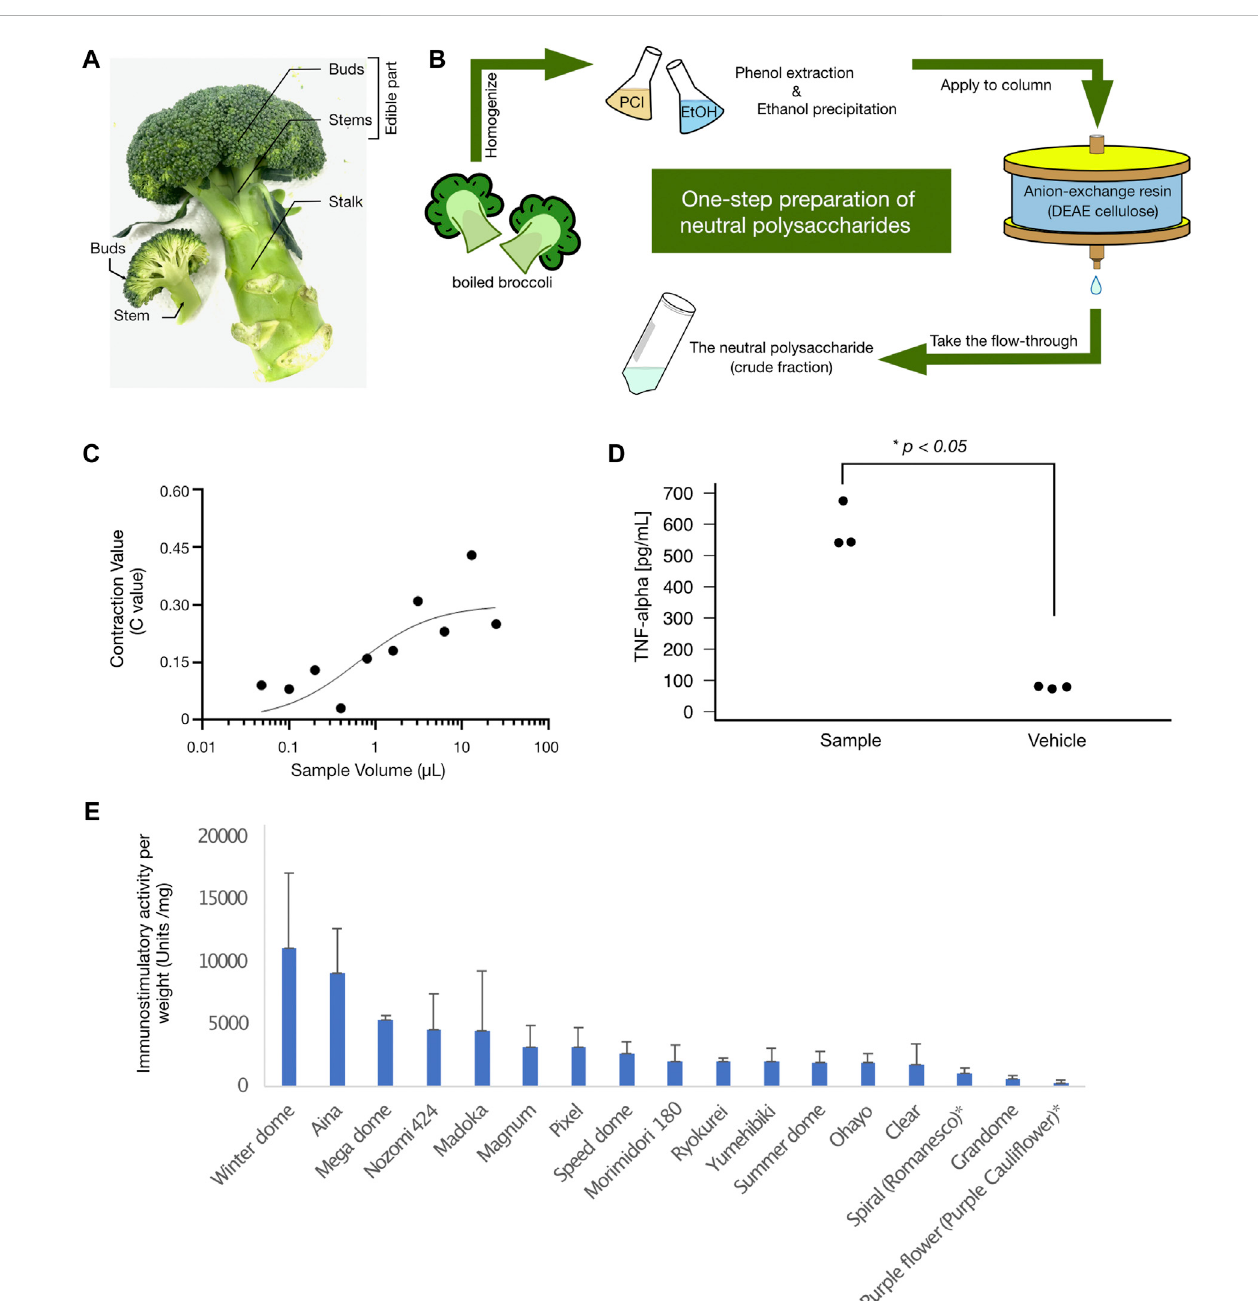
FIGURE 1 (A) The buds, stems, and stalk of broccoli. The picture represents the three parts of broccoli (buds, stems, and stalks) as described in the Materials and Methods section. In this study, broccoli was broken down into these three parts and hot water extracts were prepared separately. The immunostimulatory activity of each part is summarized in Table 1. (B) The scheme of the neutral polysaccharide preparation from broccoli. Shown in the panel is a simpli fi ed scheme for the preparation of neutral polysaccharides from broccoli: PCI, phenol-chloroform-isoamyl alcohol; DEAE, diethylaminoethyl. For a detailed description of each step, please refer to the Materials and Methods section. (C) Immunostimulatory effect (silkworm muscle contraction assay) of the neutral polysaccharides of broccoli. The graph shows the dose-dependent immunostimulatory effect of a neutral polysaccharide sample prepared from broccoli cultivar No. 1 (see also Table 2 for a list of results for other cultivars). Three independent experimental replicates (replicate #1, replicate #2, and replicate #3) are shown in the panel. The vertical axis represents the C value (see Materials and Methods for how we determined the C values), and the horizontal axis represents the sample dose used in the assay. (D) The broccoli neutral polysaccharides stimulate mammalian immune cells. The graph shows the immunostimulatory activity of neutral polysaccharide from broccoli on mouse macrophage cells. The vertical axis represents the TNF-alpha concentration detectedintheculturemediumofmousemacrophagecells(pg/mL).Eachplotrepresentseachtechnicalreplicateforthemeasurement.Experimentaldetails are described in the method section. There was a statistically signi fi cant difference between the two groups (Student ’ s t-test p -value = .00013). (E) Immunostimulatory activity of different broccoli (and cauli fl ower) cultivars. Each bar chart represents the amount of immunostimulatory activity per weight (Units/mg), with an error bar that represents standard deviation. Each cultivar names are demonstrated at the bottom of the